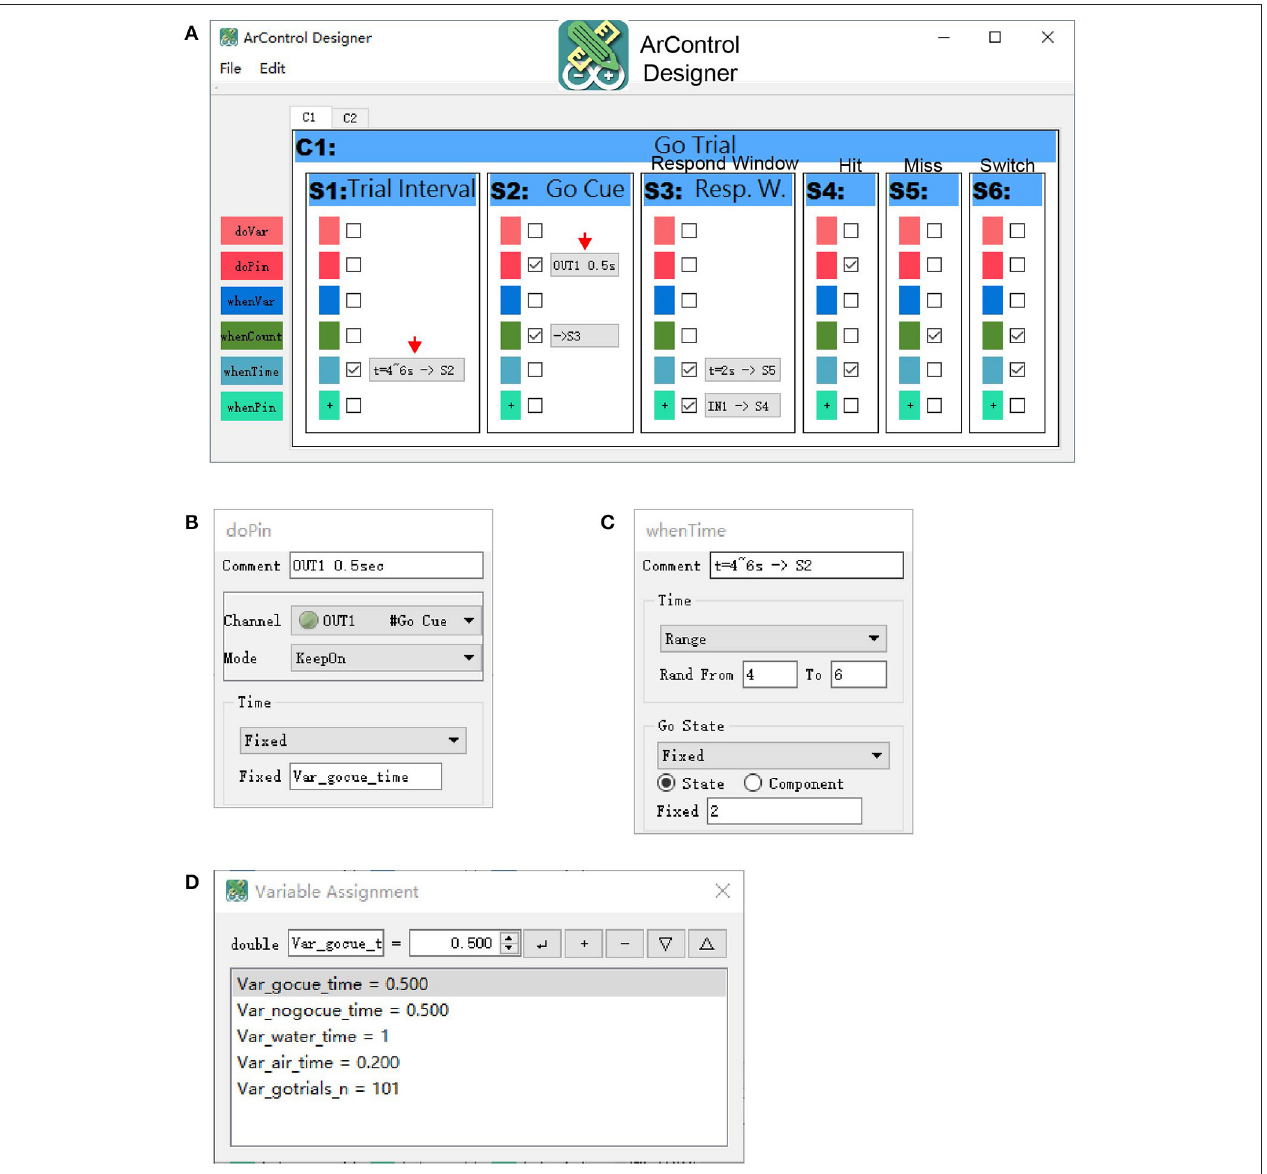
FIGURE 3 | ArControl Designer for task design. (A) Main window of the ArControl Designer shows an implementation of the Go/No-Go task. (B,C) Typical pop-up windows to configure a do-function (B) and a when-function (C). (D) Window defines and initializes the Global Variable.